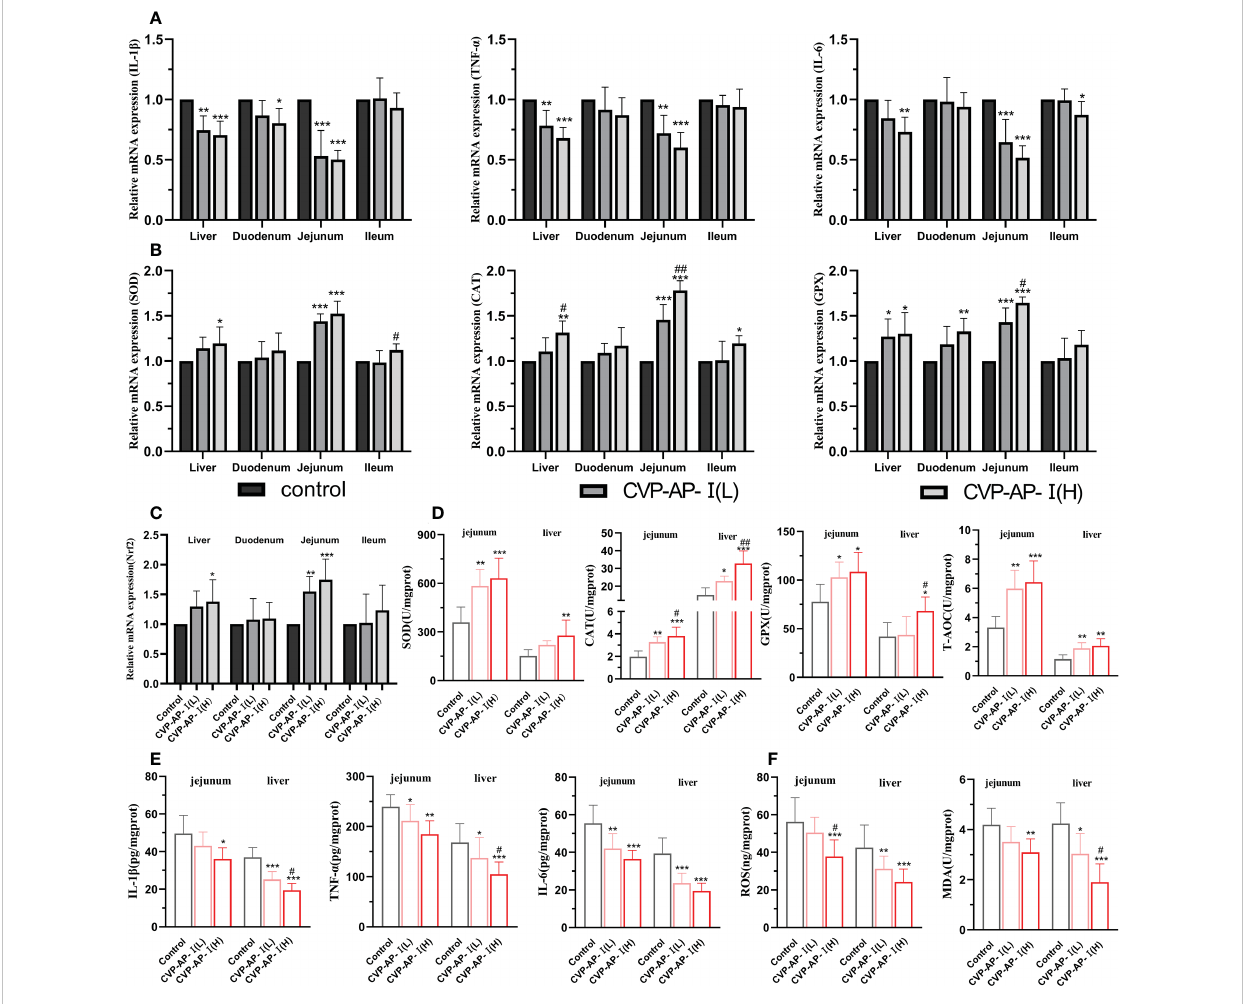
FIGURE 4 Effects of CVP-AP-I on antioxidant and anti-in fl ammatory capacity of intestine and liver in naturally aging mice. (A) qRT-PCR results show the relative expression levels of in fl ammatory factors IL-1 b , TNF- a and IL-6 genes in liver and intestinal tissues (duodenum, jejunum and ileum) of different groups of mice (n=5); (B) qRT-PCR results show the relative expression levels of the antioxidant enzymes SOD, CAT and GPX genes in liver and intestinal tissues (duodenum, jejunum and ileum) of different groups of mice (n=5); (C) qRT-PCR results show the relative expression levels of transcription factor Nrf2 gene in liver and intestinal tissues (duodenum, jejunum and ileum) of different groups of mice (n=5); (D) Quantitative results show the protein expression levels of antioxidant enzymes SOD, CAT, GPX and T-AOC in jejunum and liver of mice in different groups (n=6); (E) Quantitative results show the protein expression levels of in fl ammatory factors IL-1 b , TNF and IL-6 in jejunum and liver of mice in different groups (n=6); (F) Quantitative results show the protein expression of ROS and MDA in jejunum and liver of mice in each group (n=6); All data are represented as means ± SD. * p <0.05, ** p <0.01, and *** p <0.001 as compared with Control Group. # p <0.05 and ## p <0.01 as compared with CVP-AP-I (L)